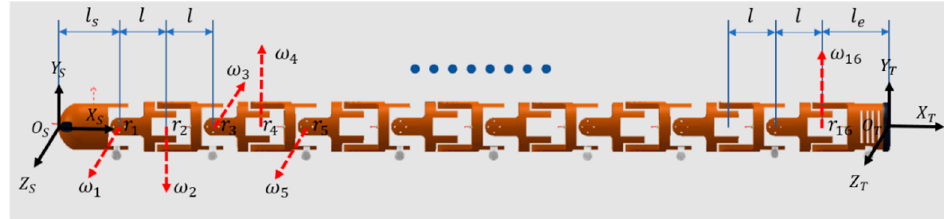
Figure 3. The screw coordinate model of snake robot.